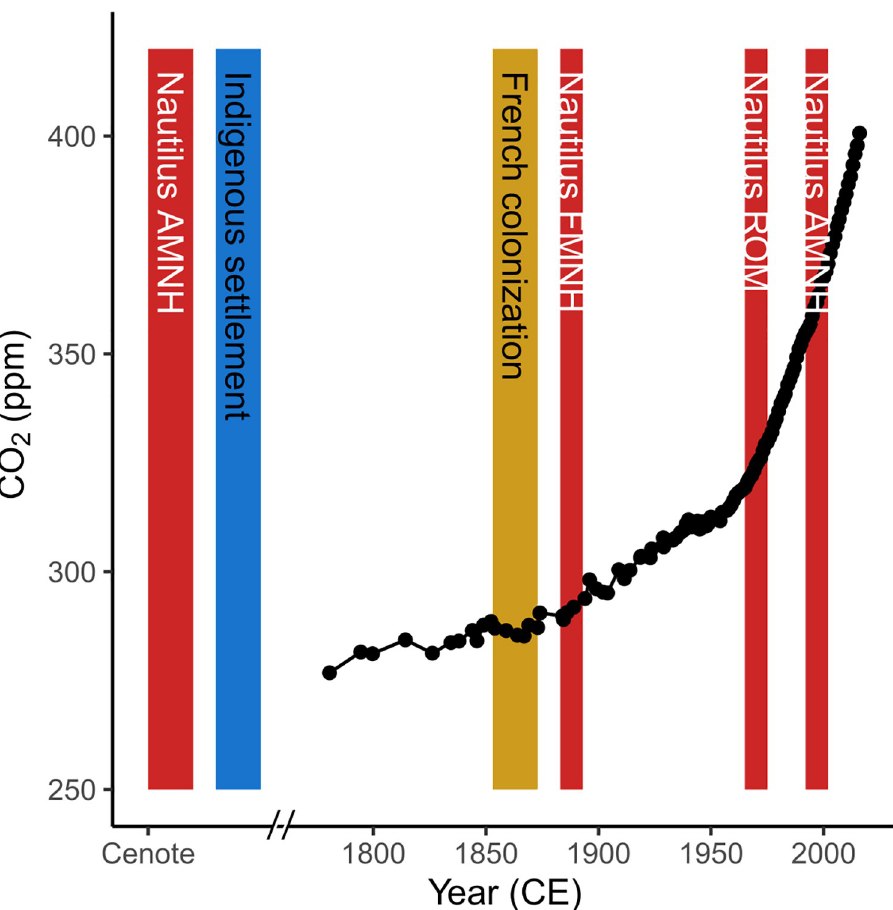
Fig 3. Timeline for sample ages, pCO 2 , and human settlement of New Caledonia. Red vertical bars represent the age of specimens used in this study with the museum repositories noted (American Museum of Natural History— AMNH, Field Museum of Natural History—FMNH, and Royal Ontario Museum—ROM). Yellow vertical bar represents indigenous settlement as demonstrated by landscape change observed in lacustrine sediments ~3000